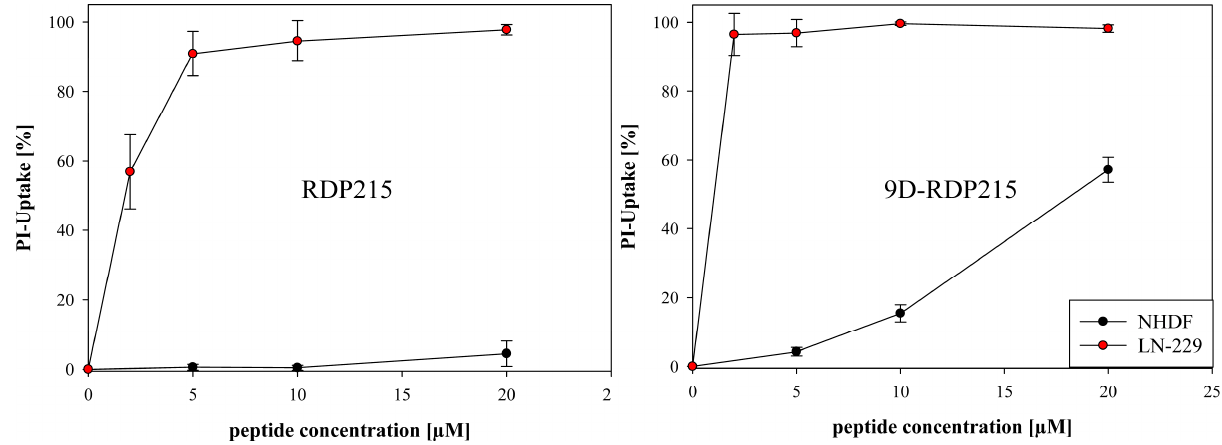
Figure 12. The cytotoxicity of RDP215 and 9D-RDP215 on glioblastoma cells LN-229 and healthy cells NHDF. Cell death was determined by PI-uptake (%) in the presence of 2 µM, 5 µM, 10 µM and 20 µM peptide concentration after 8 h of incubation. With LN-229, RDP215 already displays high peptide-induced cell death up to 90% at 5 µM. Within the studied concentration range, RDP215 exhibits no harm on NHDF cells. 9D-RDP215 shows increased antitumor and non-tumor toxicity, though still with high specificity.